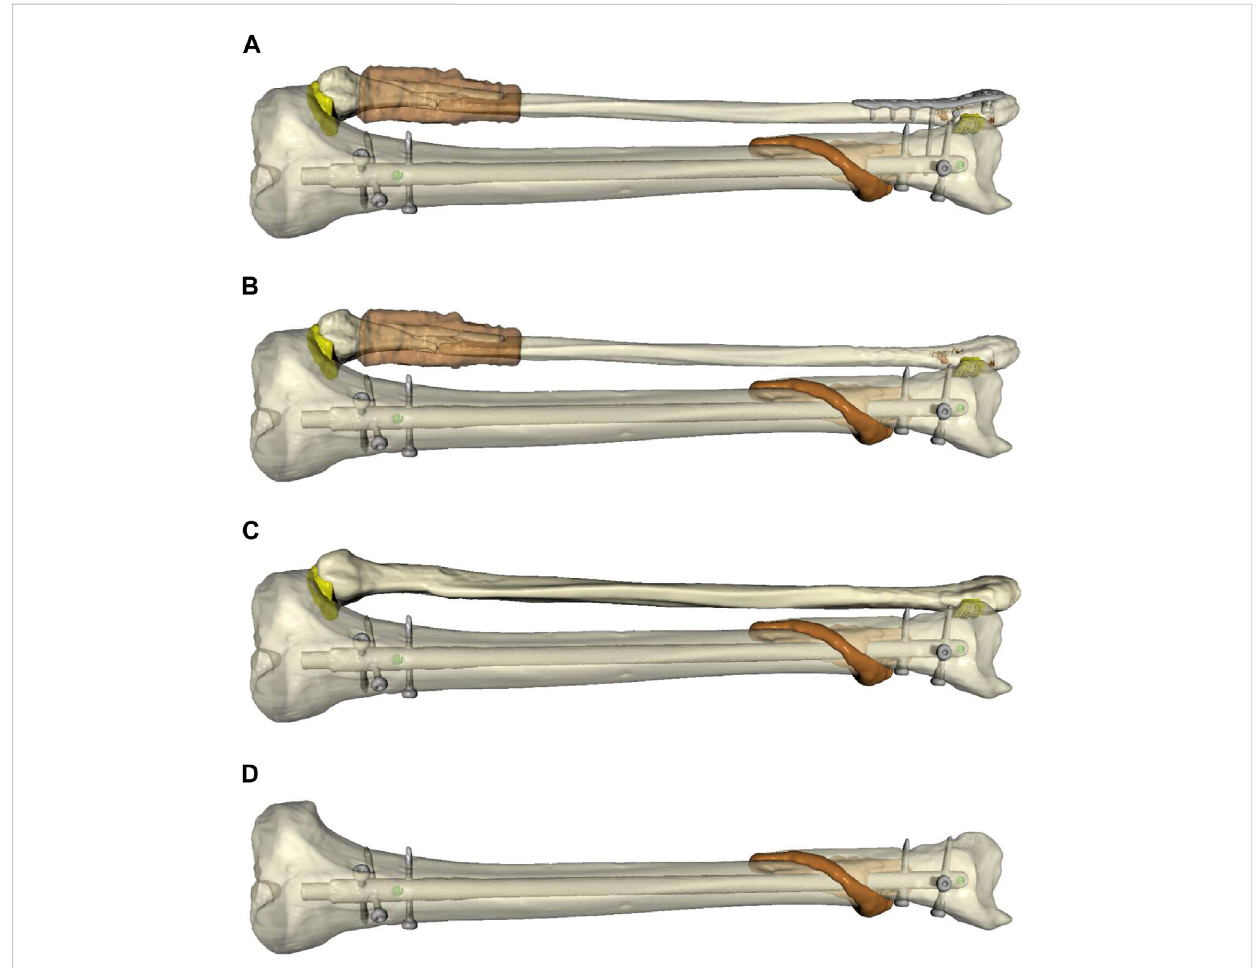
FIGURE 2 Simulatedmodels of the individualized patient ’ s lower leg to compare different forms of biomechanical stability and surgical treatmentoptions. (A) : Plate osteosynthesis of the distal fi bular fracture and intramedullary nailing of the tibia, which resembles the real treatment of the patient (FibOP). (B) : Untreated fi bula (Fib#). (C) : Intact fi bula (Fib). (D) : Removed fi bula, only simulation of the treated fi bula